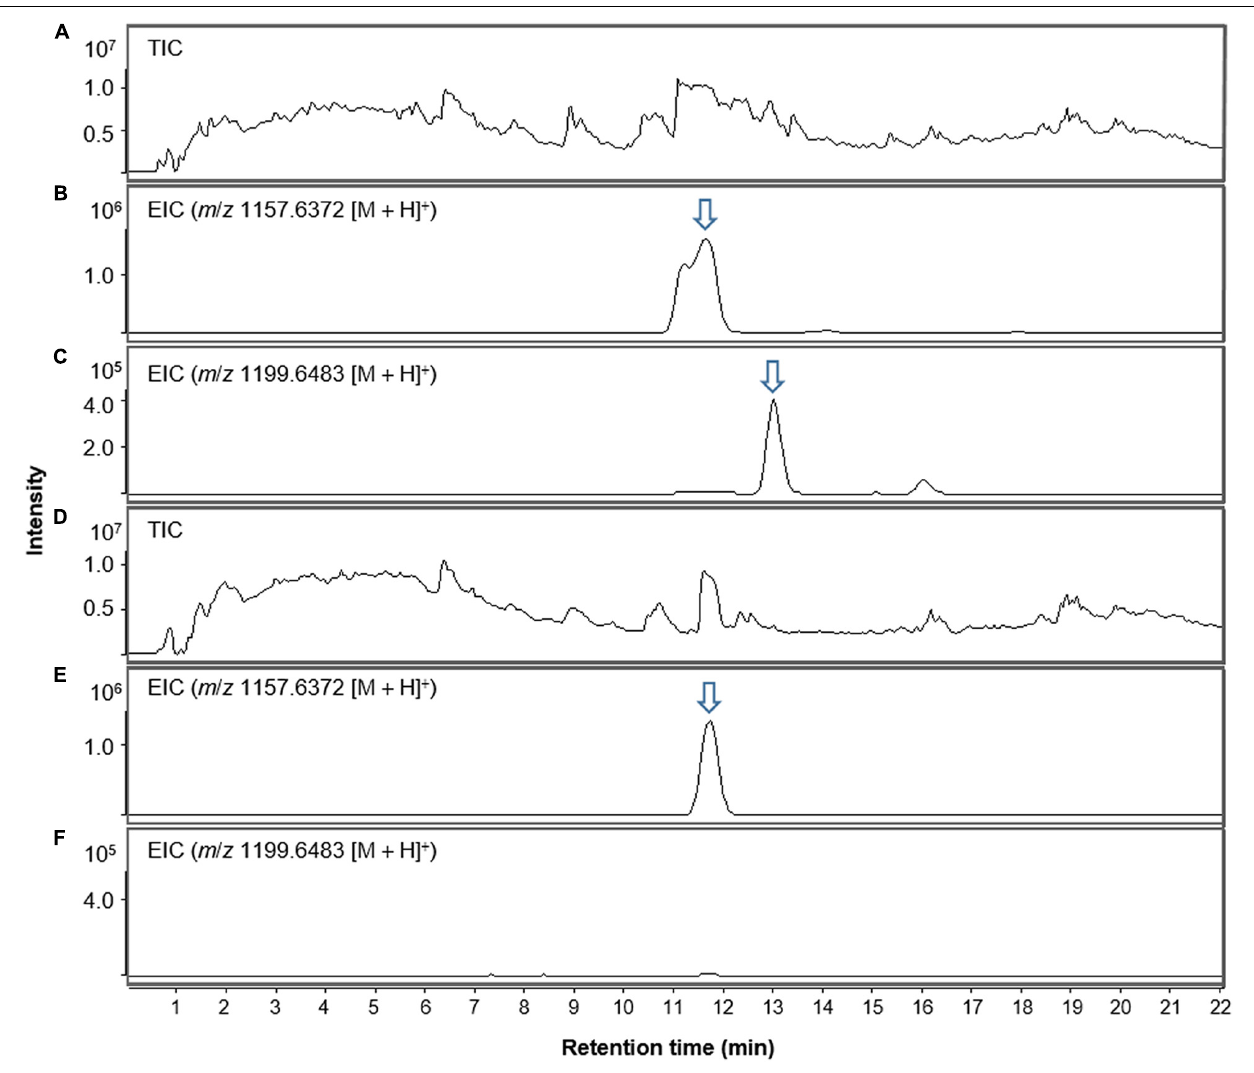
FIGURE 4 | LC-MS chromatogram comparison of S. olivaceus JB1 culture extract in non-saline and saline media (salinity; 33 per mille of sodium chloride) in positive ion mode. (A) Total ion current (TIC) chromatogram of non-saline liquid culture broth of S. olivaceus JB1. (B) Extracted-ion chromatogram (EIC) of the